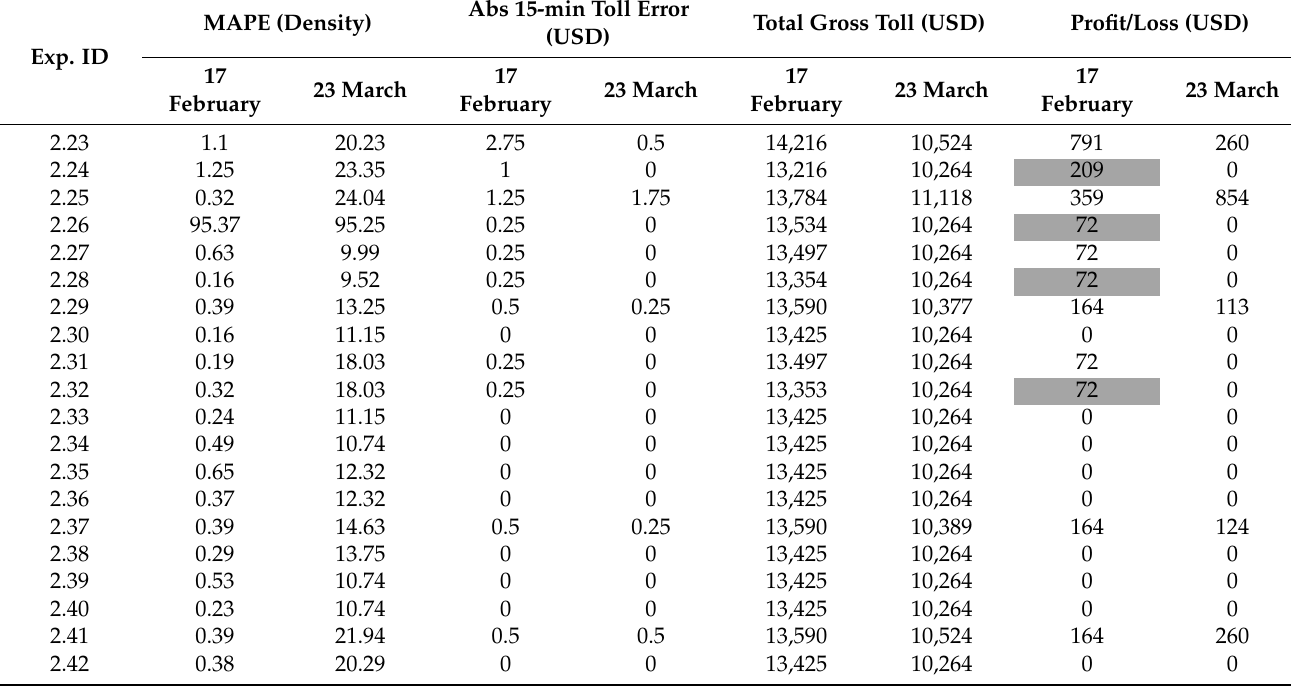
Table 8. Results of stochastic detection scenario for Northbound